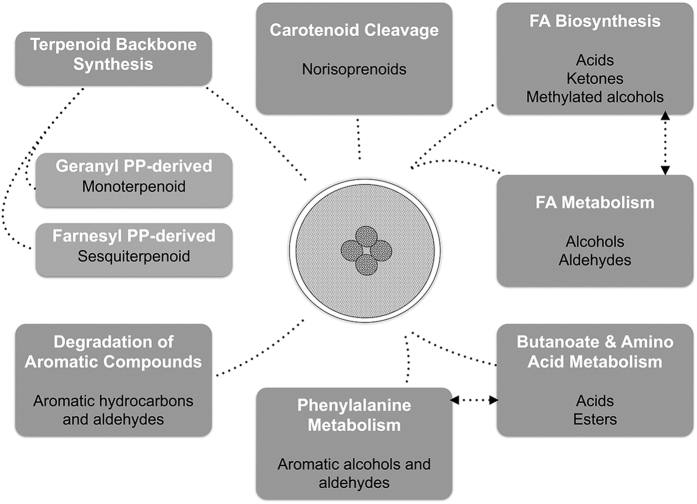
Schematic representation proposed to explain A. nigermetabolic pathways related to molecular biomarkers pattern chemical families2536373839.FA – Fatty Acid; PP – Diphosphate.